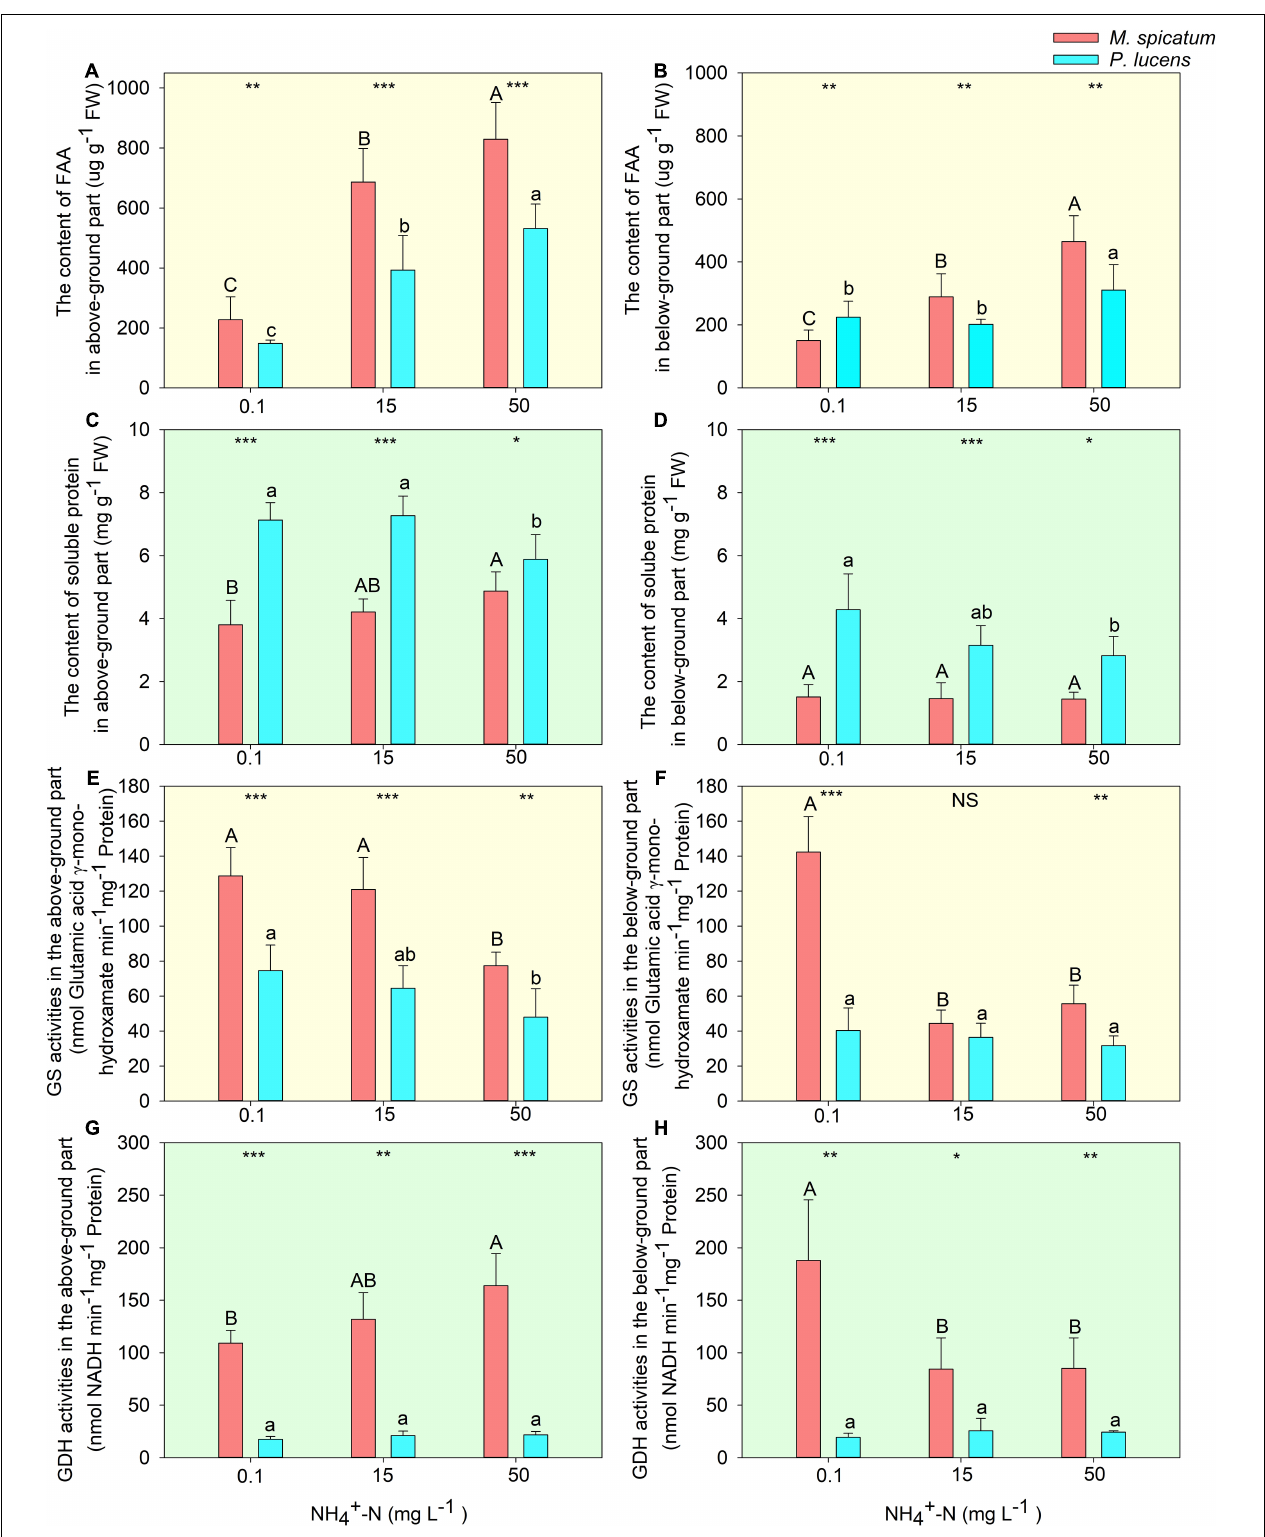
FIGURE 2 | Estimation of nitrogen allocation and ammonium assimilation in plants. The effect of [NH 4 + -N] on the content of FAA (A,B) , soluble protein (C,D) , enzymes activities of GS (E,F) , and GDH (G,H) in the above- and below-ground parts of M. spicatum (red bar) and P. lucens (blue bar). Different letters represent significant differences ( p < 0.05), capital letters: M. spicatum , lowercase letters: P. lucens . Statistical differences between the two species are designed as follows: * p < 0.05, ** p < 0.01, *** p < 0.001, NS stands for no significance, based on the Student’s t -tests.